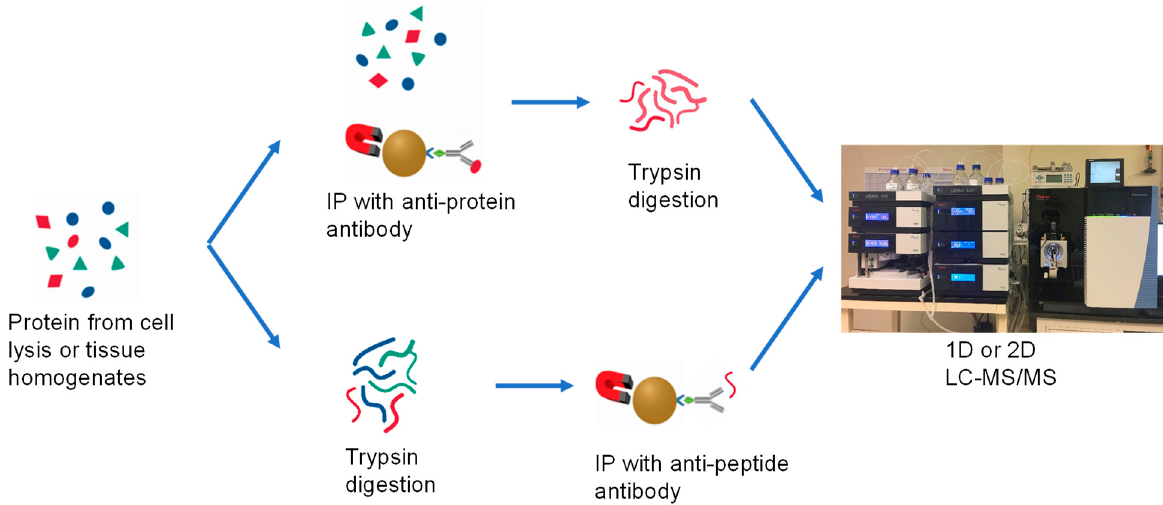
Figure 1. Two typical workflows for immunoprecipitation of the proteins from biological samples.